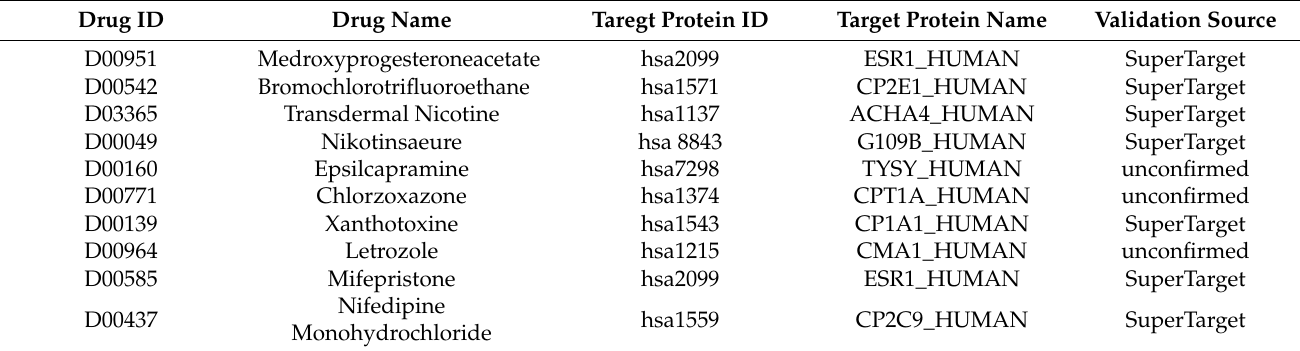
Table 9. Top 10 DTI pairs predicted by